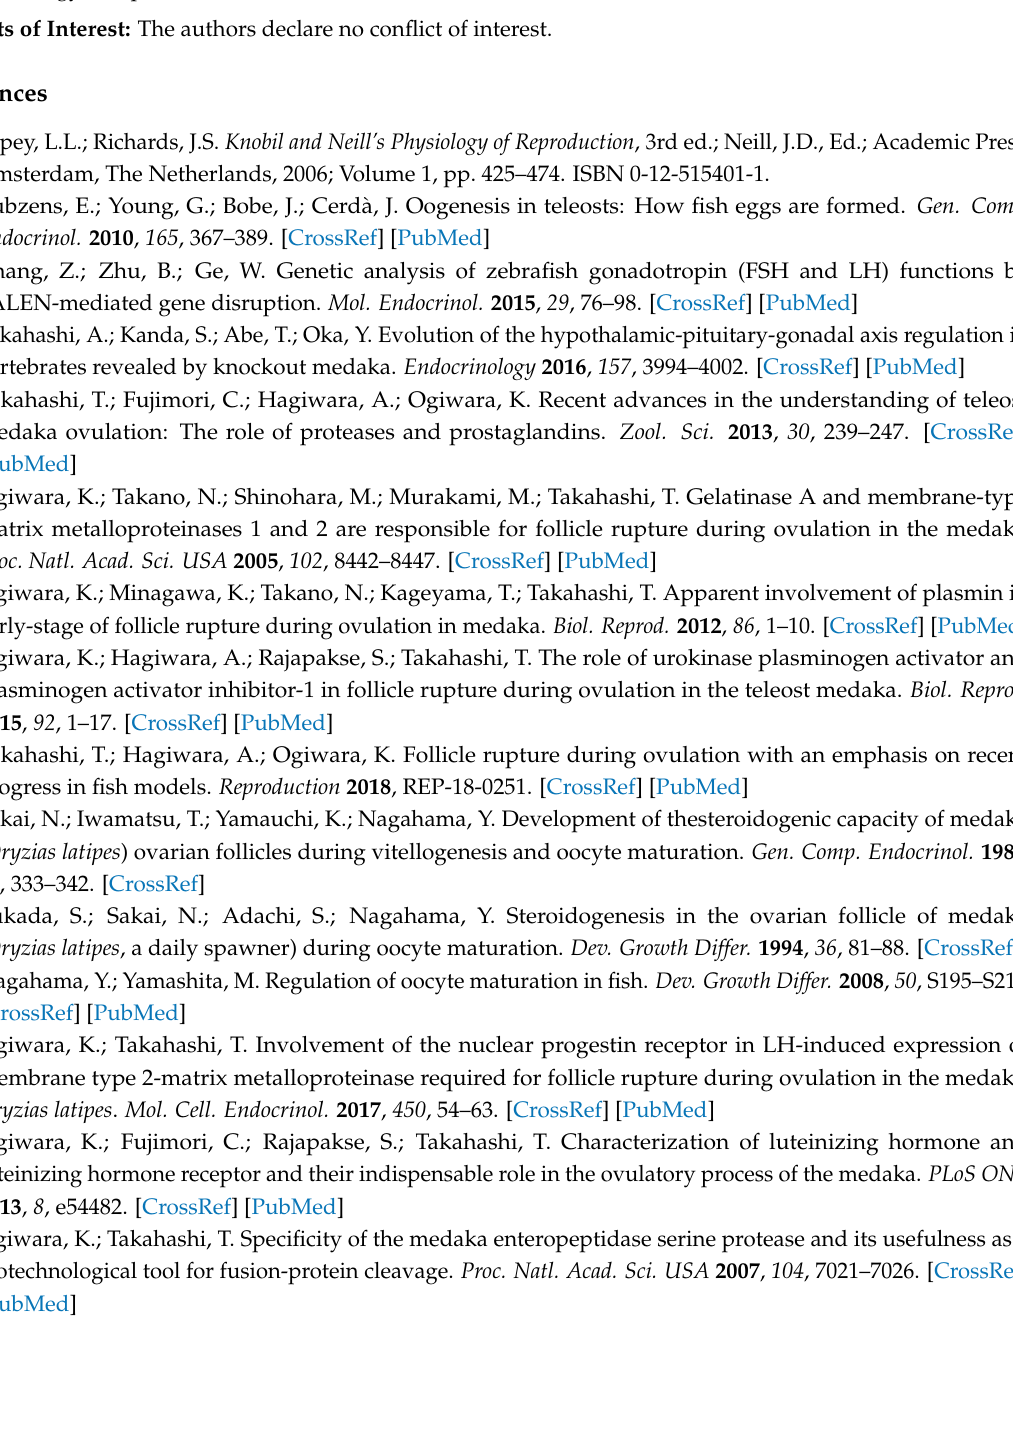
Figure S1: Expression of cdk1 , cdk9 , and cdk11b mRNA in medaka preovulatory follicles during 24 h-spawning cycle, Figure S2: Characterization of antibodies prepared in this study, Figure S3: Expression of cdk1, cdk9, and cdk11b mRNA in preovulatory follicles cultured with or without roscovitine, Table S1: PCR primers used in this